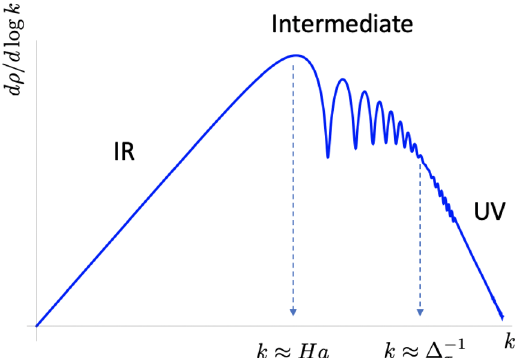
Figure 3 . Illustration of the k (frequency) dependence of different parts of a typical GW spectrum. The signal typically peaks around k ≈ H ? a ? , with an oscillatory feature in the range H ? a ? < k < ∆ − 1 τ